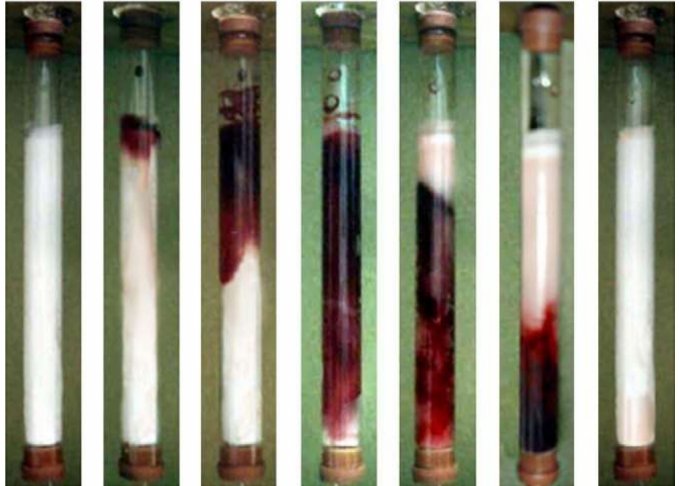
Figure 3. The flow pattern of human blood through a supermacroporous cryogel. Republished with permission from [47]. Copyright 2009